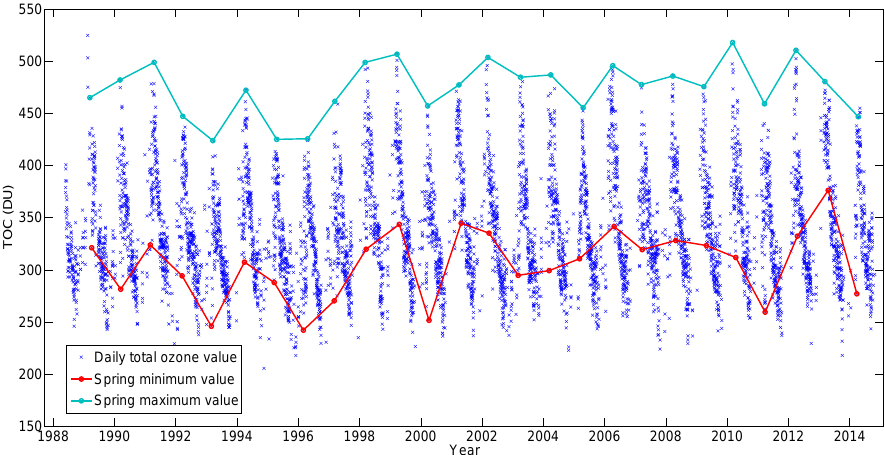
Figure 1. Total ozone column daily average time series with spring time extreme values highlighted for each year. For the spring, minima and maxima measurements from March and April are